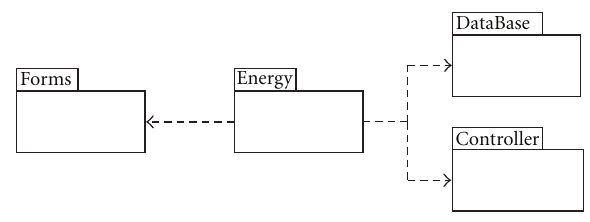
Figure 1: The SolarEnergy